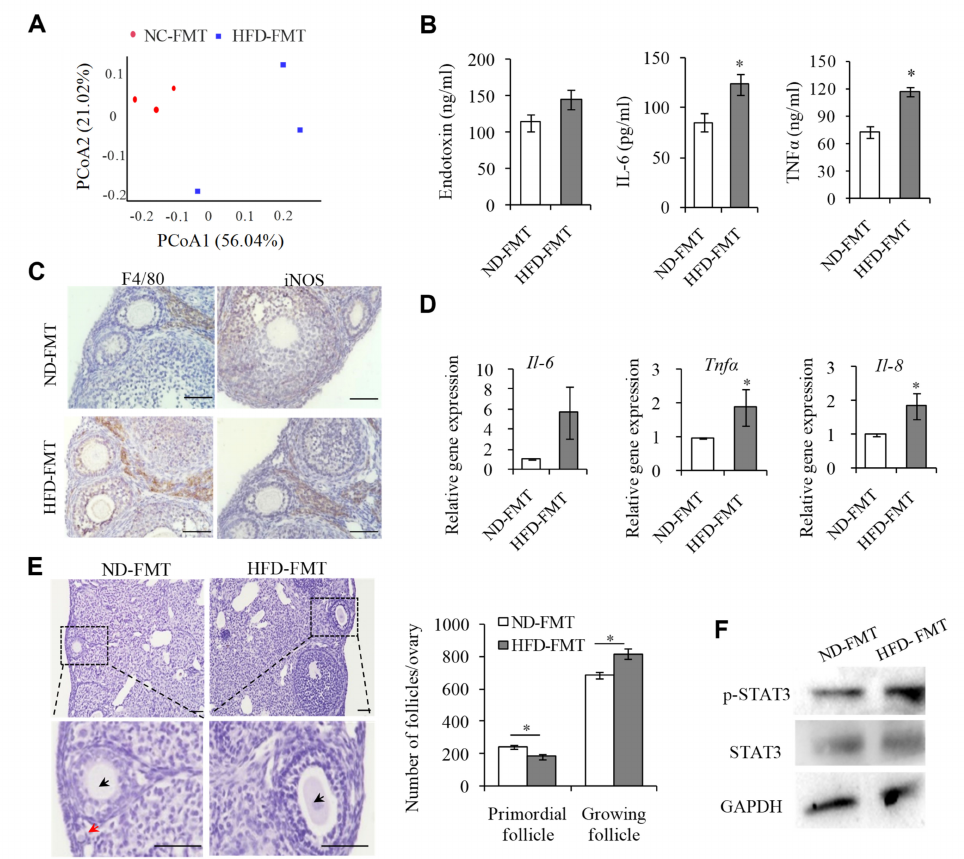
Figure 6. Transplantation of HFD gut microbiome leads to endotoxemia, infiltration of ovarian macrophages, and decreased primordial follicle pool. ( A ) Principal coordinate analysis (PCoA) graph based on the operational taxonomic unit (OTU) matrix of ND-FMT and HFD-FMT fecal microbiota ( n = 3). ( B ) ELISIA analysis of serum concentration of endotoxin, IL-6, and TNF α in ND-FMT and HFD-FMT groups ( n = 5). ( C ) Immunohistochemistry analysis of F4/80 and iNOS in ND-FMT and HFD-FMT mouse ovaries. Scale bar = 50 µ m. ( D ) The mRNA levels of Il-6, Tnf α , and Il-8 in ND-FMT and HFD-FMT ovaries determined by qPCR assay. ( E ) Representative H&E staining images and follicle number counts in ND-FMT and HFD-FMT mouse ovaries. Red arrows represent primordial follicles. Black arrows represent growing follicles. * p < 0.05. Scale bar = 100 µ m. ( F ) WB analysis of the protein levels of p-STAT3, STAT3, and GAPDH in ND-FMT and HFD-FMT mouse